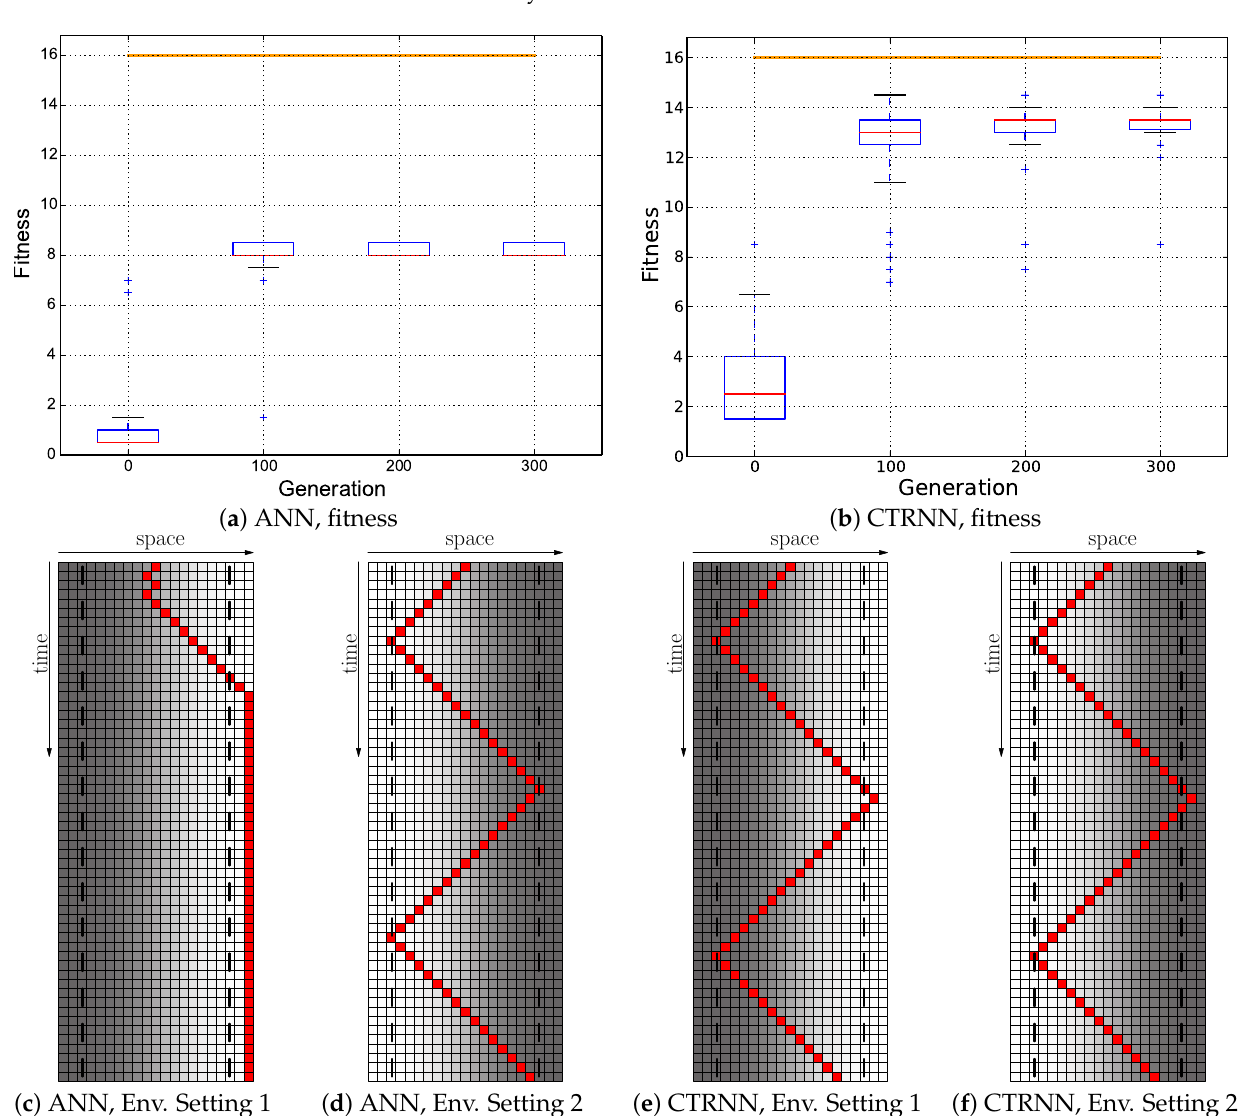
Figure 7. Evolutionary results of the double environment setting, fitness regime Switch : fitness = F ( 1,0,0 ) . The arithmetic mean of both evaluations was used as the fitness value for a genome. Top row: fitness dynamics of the ANNs (left) and CTRNNs (right). The horizontal orange line indicates the maximum fitness achievable by a reactive Wankelmut controller, as it was achieved by the simple hand-coded controller. Bottom row: trajectory of the best performing genome of both controller types in both environments used in evolution (only the initial 56 time steps of 250 time steps are